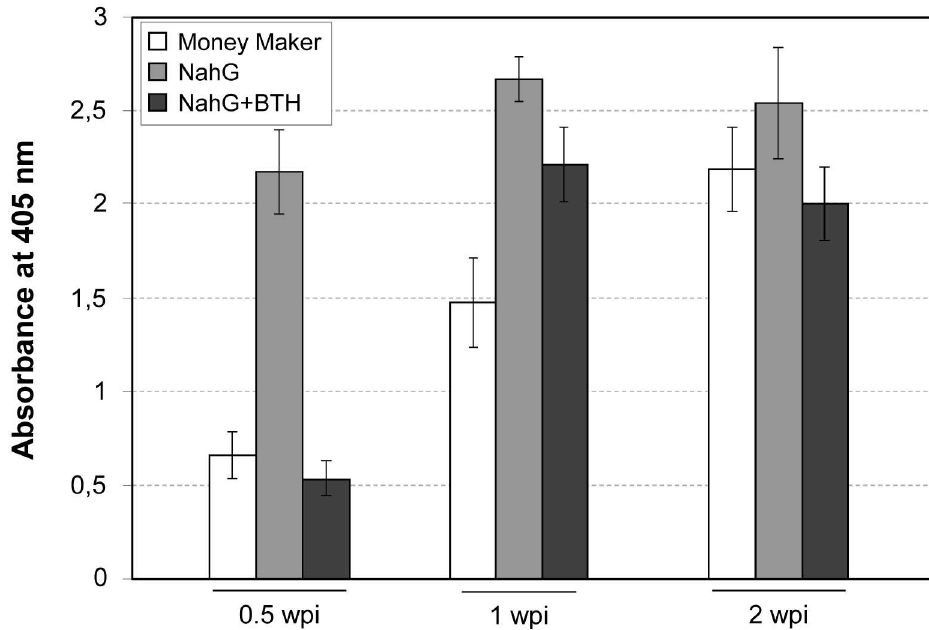
Fig 8. Detection of TSWV levels in infected Money Maker, NahG and BTH-treated NahG plants. Quantitative ELISA to detect TSWV at 0.5, 1 and 2 wpi. A polyclonal antibodyagainst TSWV (BR-01, Loewe) and an alkalinephosphatase conjugated antibody were used as primary and secondary antibodies, respectively. Immunodetection was carried out by using p-nitrophenyl phosphate as a substrate and the absorbance was measuredat 405 nm. Data correspondto the mean ± SD of three biological replicates of one representative experiment.